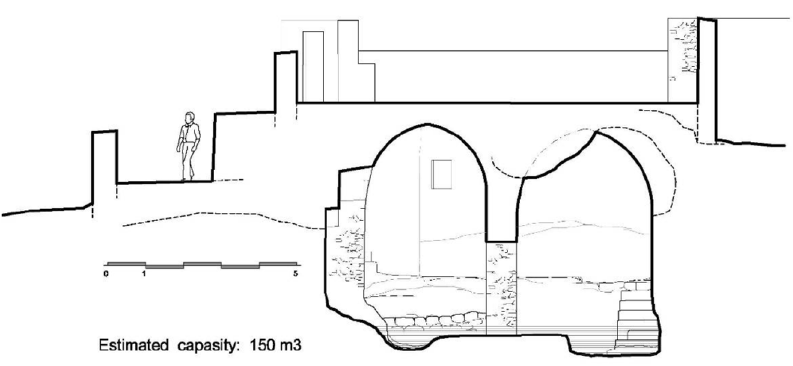
Figure 8. Kato Lakkos medieval cistern, Chora Amorgos. Cross section facing north (G. P. Anto- niou).